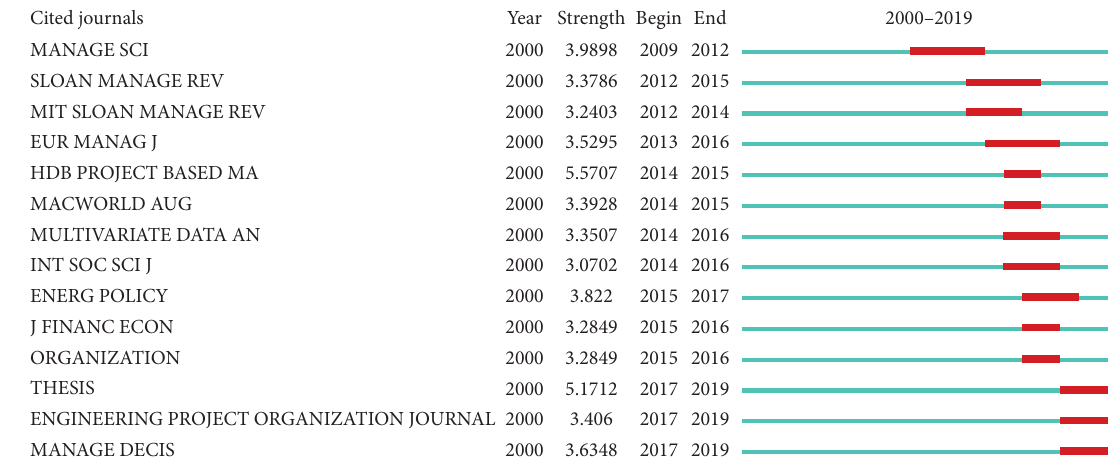
Figure 8: Cited sources with the strongest citation bursts.